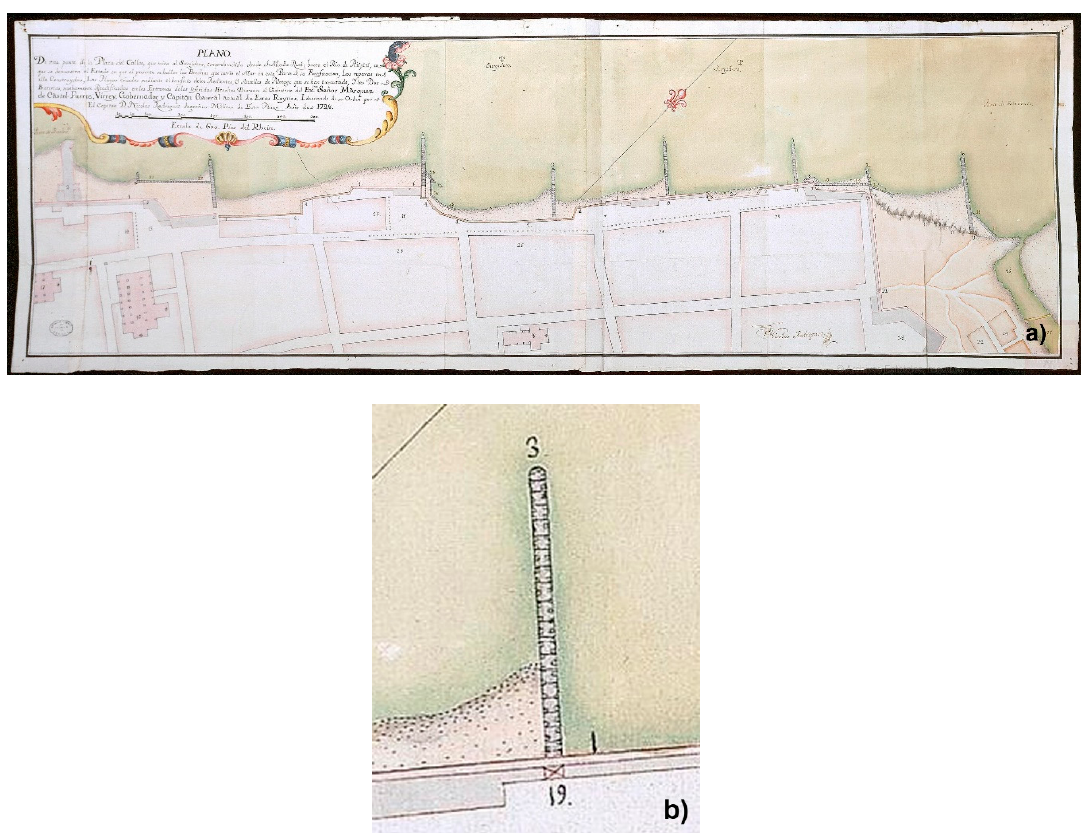
Figure 10. ( a ) Groins at Callao in 1728; ( b ) Detail on a groin [37]. In the cartouche : Map of a part of Callao (…) in which the state of the breaches done by the sea in this part of the wall is shown, together (…). Courtesy: Archivo general de Indias,